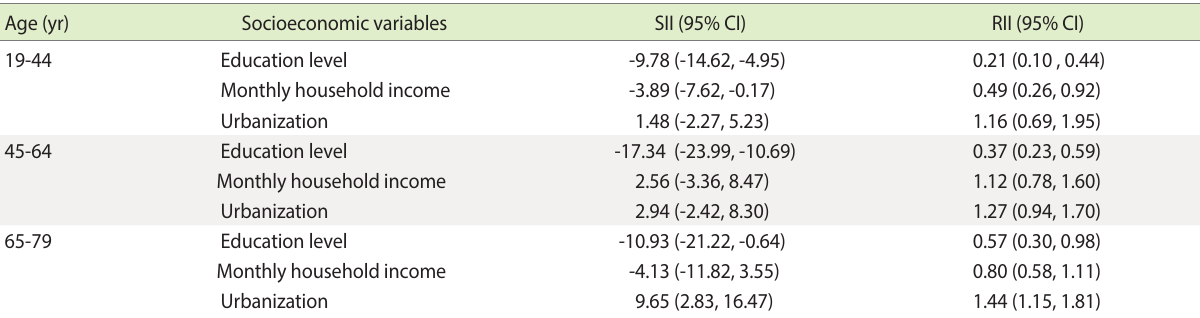
SII, slope index of inequality; RII, relative index of inequality; CI, confidence interval. 1 Adjusted for self-reported health status and